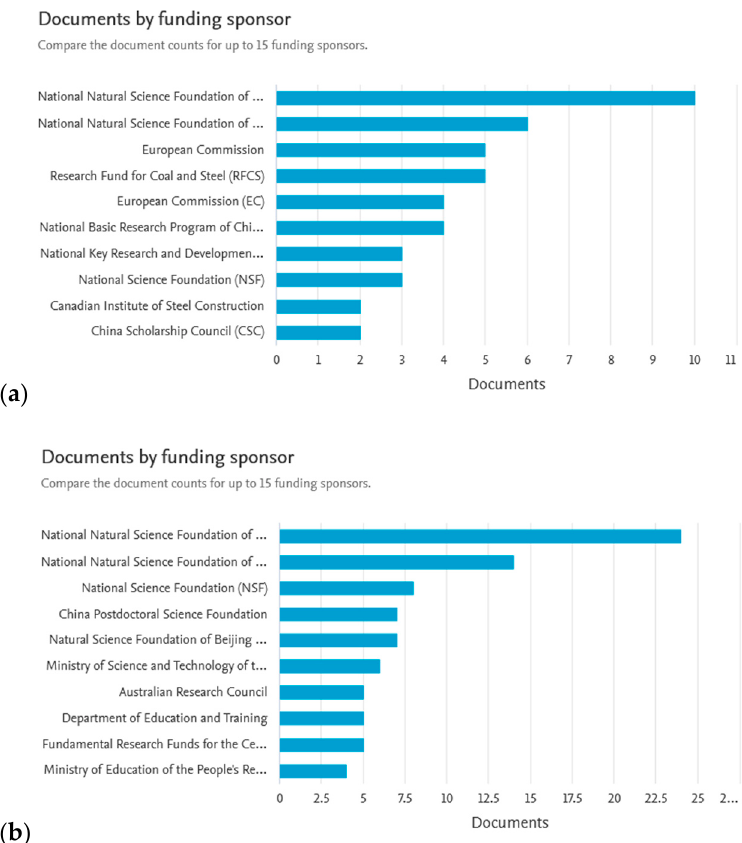
Figure 4. Funding sponsor for ( a ) “Seismic design” AND “Steel joints” OR “Steel Connections” OR “Bolted connections” OR “Bolted joints” and ( b ) “ Earthquake ” AND “ Steel joints ” OR “ Steel Connections ” OR “ Bolted connections ” OR “ Bolted joints ”.